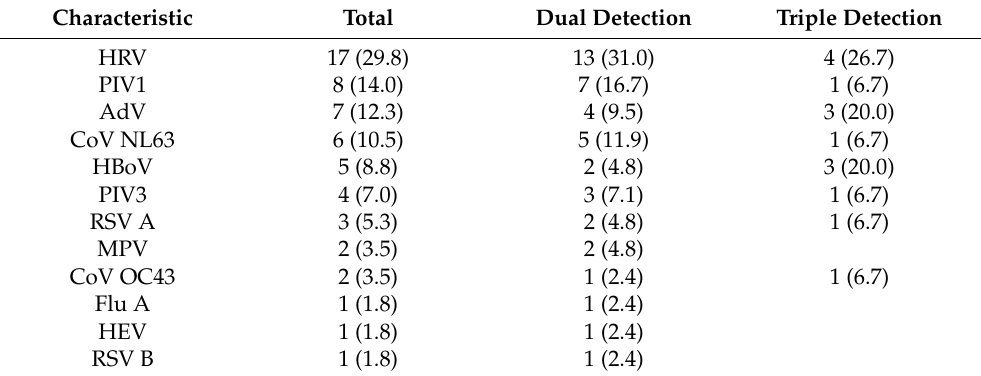
Table 3. Respiratory virus codetection in children diagnosed with croup during 2018–2022, South